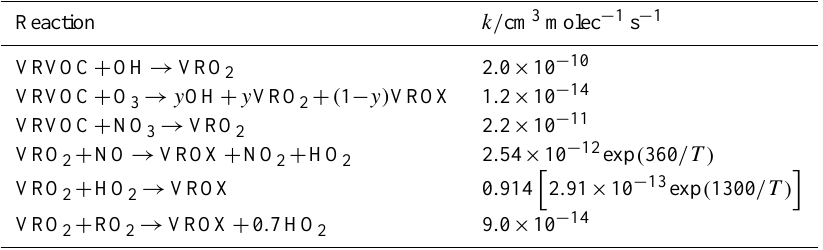
Table 1. Chemical reactions for VRVOC. Rate constants for initial oxidation reactions are the same as those used for β -caryophyllene (Bouvier-Brown et al., 2009b; Wolfe and Thornton, 2011). The yield of OH and VRO 2 from VRVOC ozonolysis ( y ) is taken as an adjustable constant ranging from 0 to 1. Rate constants and product yields for reactions of peroxy radicals (VRO 2 ) are the same as those for β -pinene RO 2